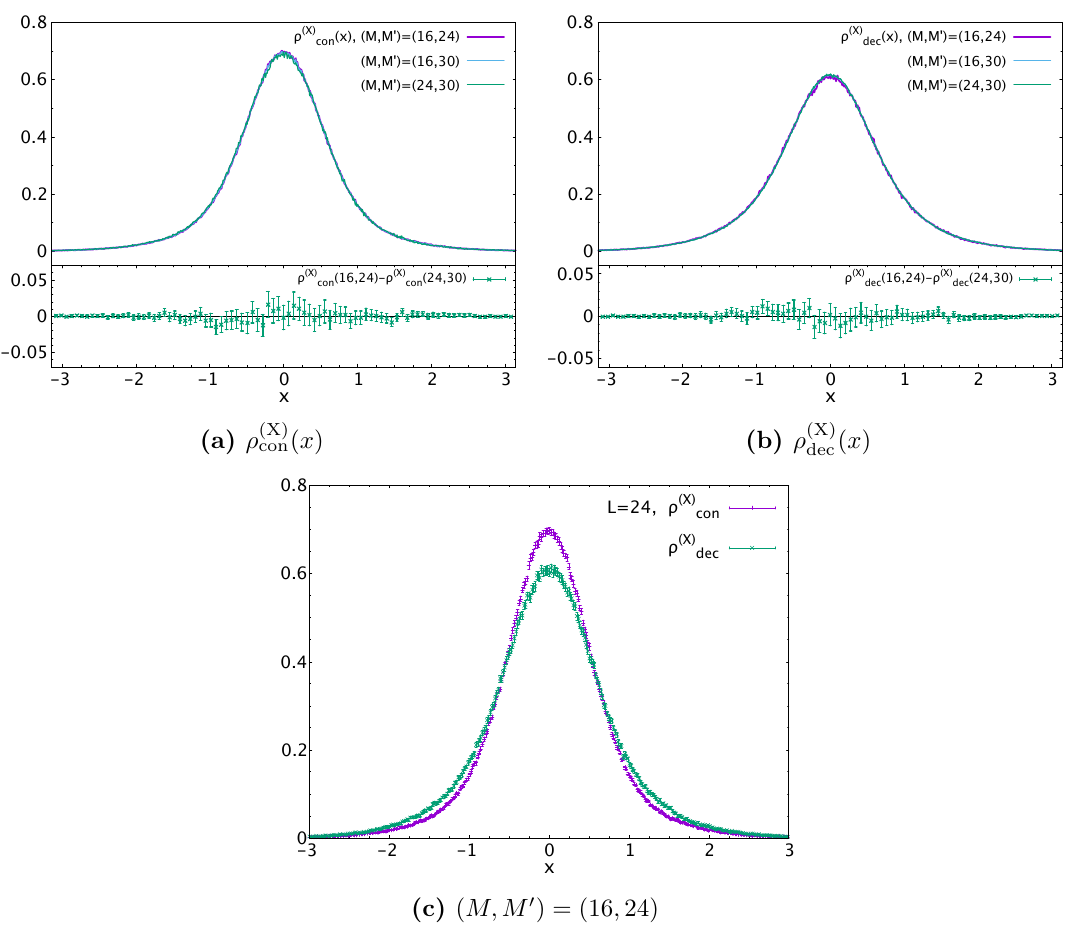
Figure 5. ρ (X) con ( x ) and ρ (X) ( x ) obtained from the Gaussian Matrix model, d = 2 , N = 32 , number dec of lattice sites L = 24 , at T = T c = 1 . By using different combinations of M and M 0 , the same log2 distribution is obtained. The error bars in each figure are obtained by jackknife